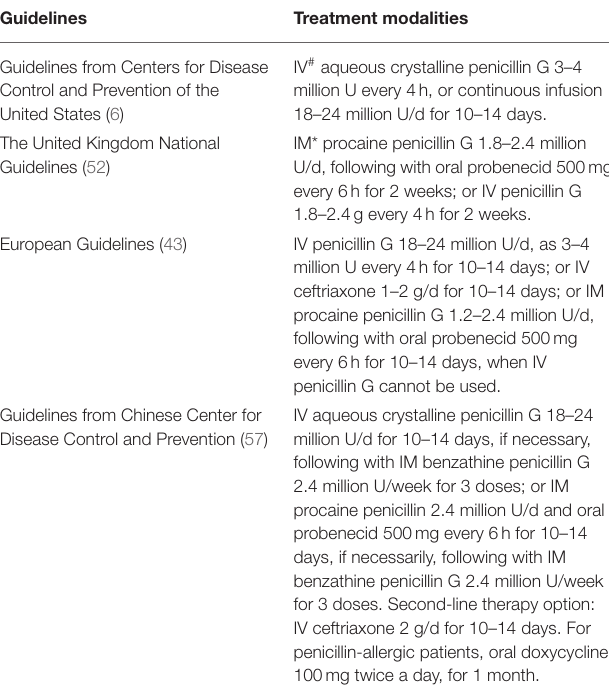
TABLE 1 | Treatment recommendations for